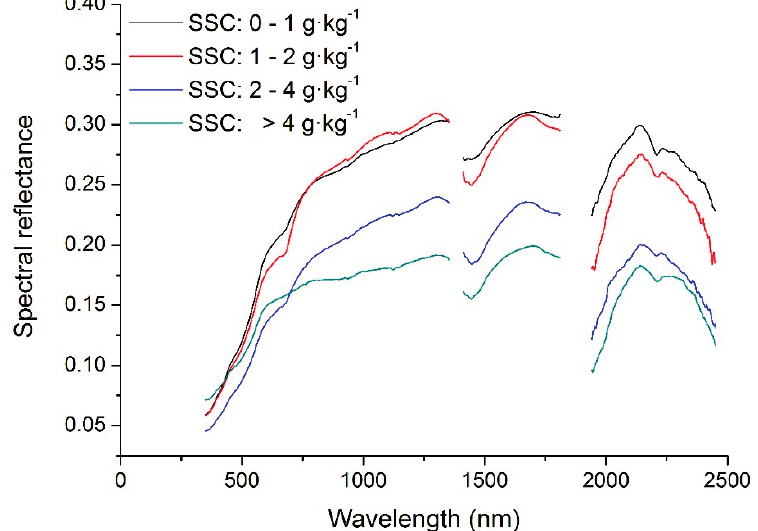
Figure 3. Mean spectral reflectance for soils at different saline levels. Non-saline, slightly saline, moderately saline and highly saline soils are defined in terms of soil salinity value as 0 < SSC < 1 g·kg − 1 , 1 < SSC < 2 g·kg − 1 , 2 < SSC < 4 g·kg − 1 and SSC > 4 g·kg − 1